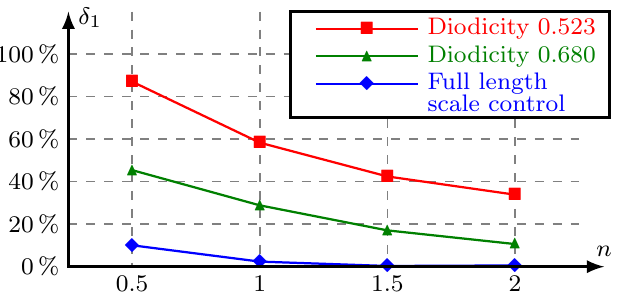
Figure 9. The difference δ 1 of three optimization results between 2D and 3D models with the ratio of depth to width of the inlet n .